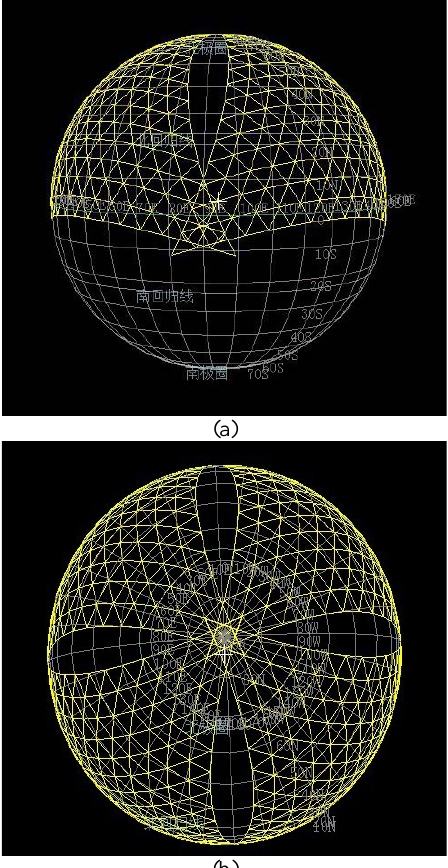
Figure 3 visualization of azimuthal projection